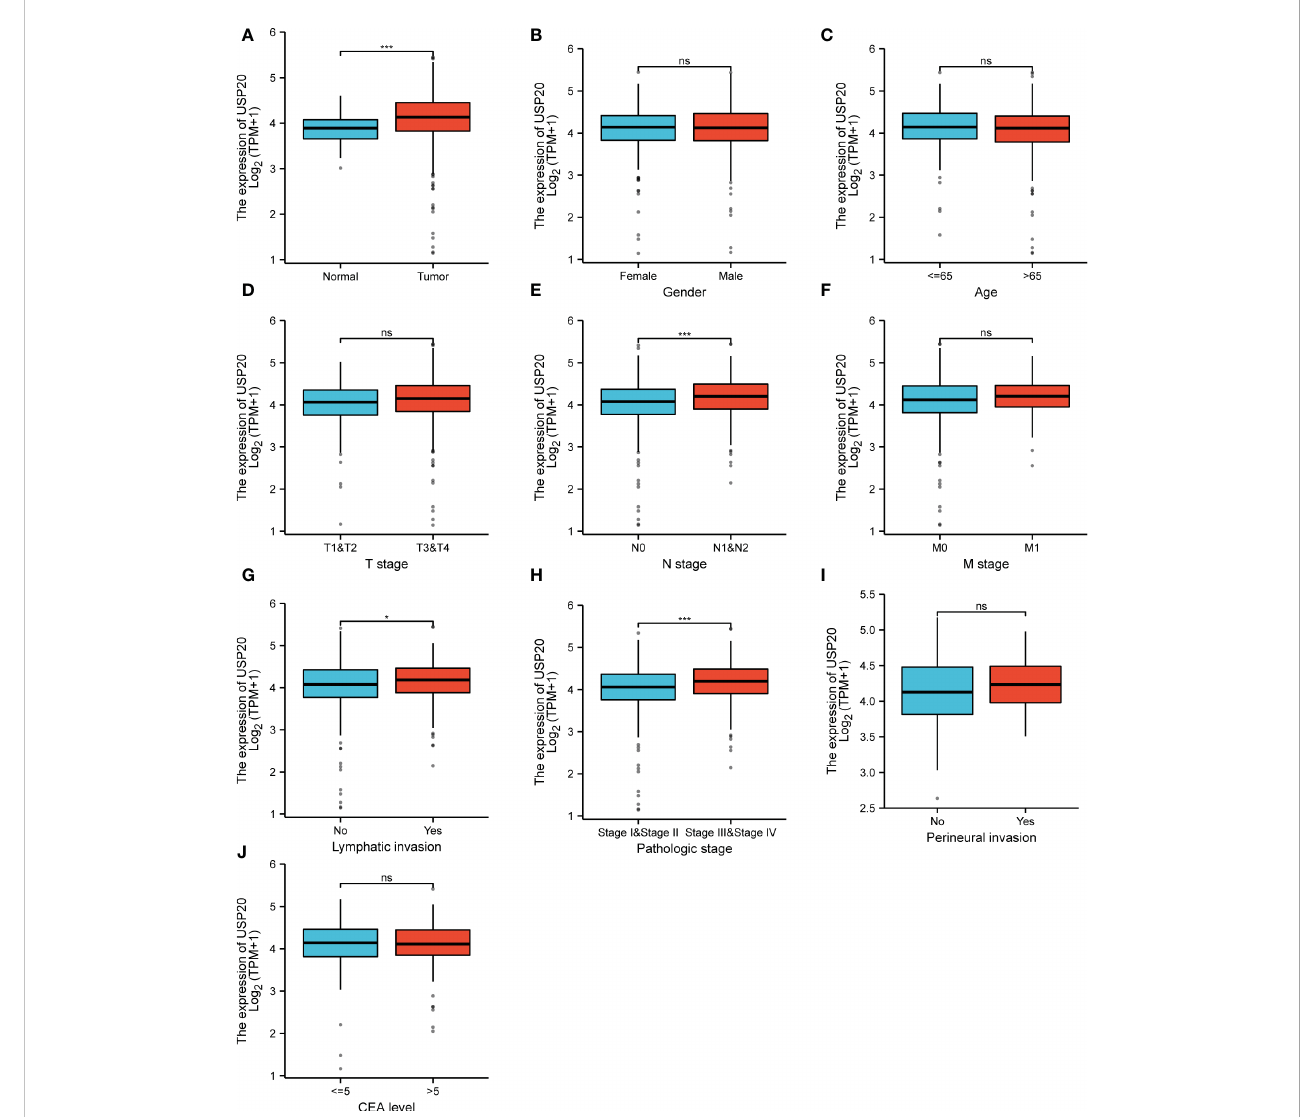
FIGURE 2 Relationship between USP20 expression and CRC patient clinicopathological characteristics in TCGA; (A) analysis of USP20 expression between normal and cancer tissues; (B) analysis of USP20 expression between female CRC patients and male CRC patients; (C) analysis of USP20 expression between CRC patients who were younger than or older than 65 years of age; (D) analysis of USP20 expression between T1&T2 CRC patients and T3&T4 CRC patients; (E) analysis of USP20 expression between N0 CRC patients and N1&N2 CRC patients; (F) analysis of USP20 expression between M0 CRC patients and M1 CRC patients; (G) analysis of USP20 expression between CRC patients who with lymphatic invasion or not; (H) analysis of USP20 expression between pathologic stage I& stage II CRC patients and stage III& stage IV CRC patients; (I) analysis of USP20 expression between CRC patients who with perineural invasion or not; (J) analysis of USP20 expression between CRC patients who CEA levels more than or less than 5; (*P < 0.05; **P < 0.01; ***P < 0.001; ****P < 0.0001; NS, not signi fi cant). (*P <0.05; ***P < 0.001; NS, not signi fi